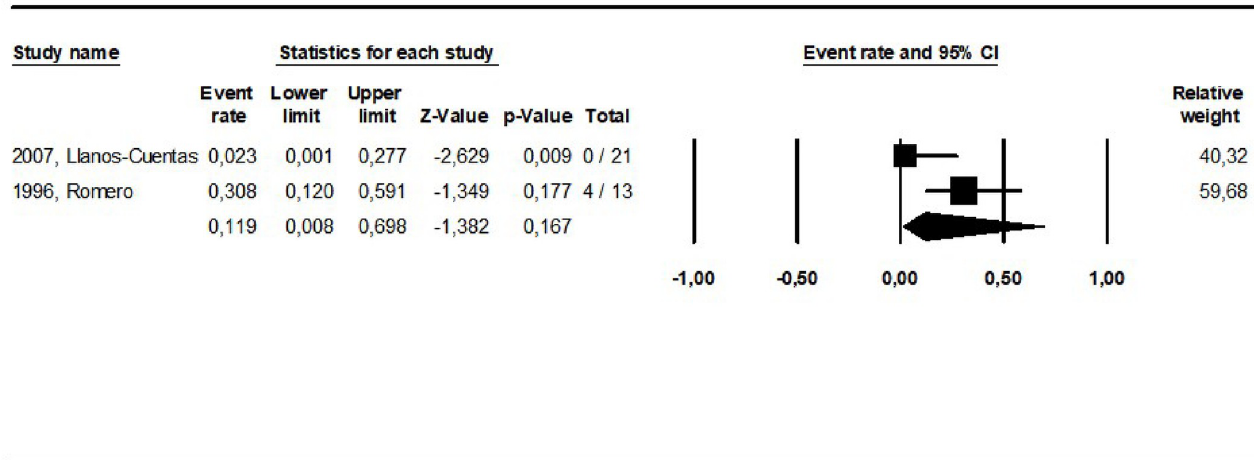
Fig 8. Pooled cure rate including all patients treated for ML with aminosidine in the reviewed